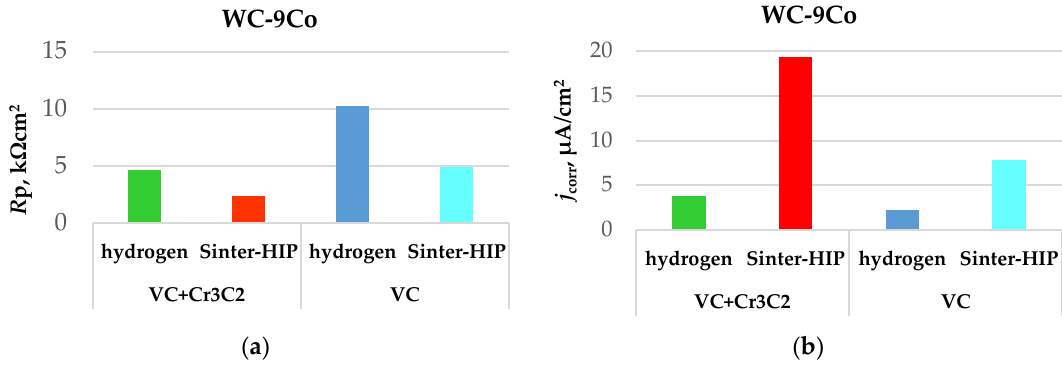
Figure 4. Correlation of electrochemical parameters and GGIs for WC-9Co. ( a ) Correlation of polarisation resistance and GGIs; ( b ) Correlation of corrosion current density and GGIs.